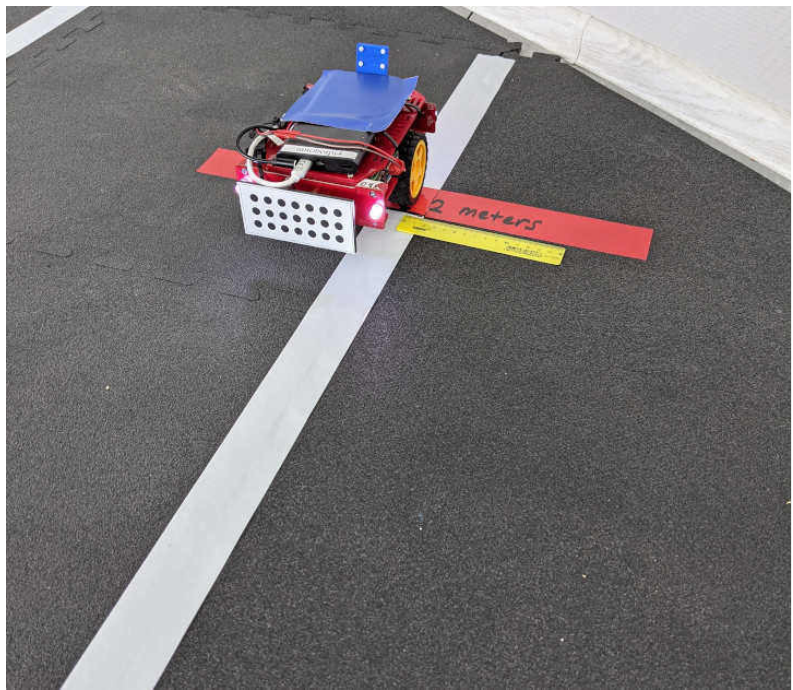
Figure 3. Measurement of wheel calibration error after driving along a two-meter